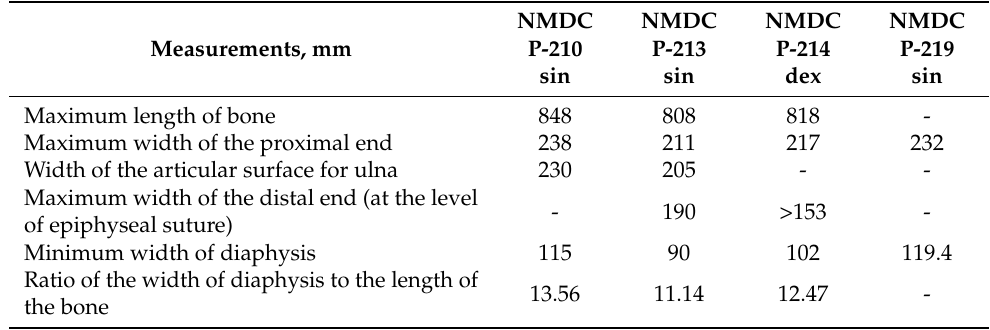
Table 3. Measurements of the ulna of Mammuthus intermedius from Kamensk-Shakhtinskiy (the early Late Pleistocene; Rostov Region,